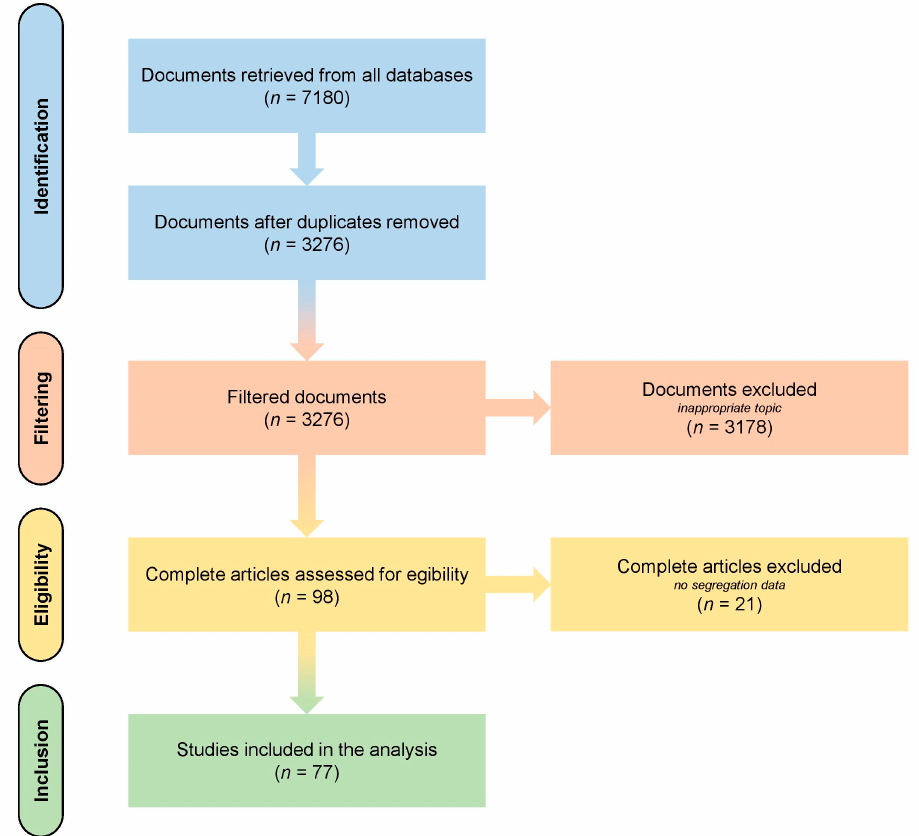
Figure 5. Flow diagram of the studies . The studies included in the analysis are listed in the Supple- mentary Materials Table